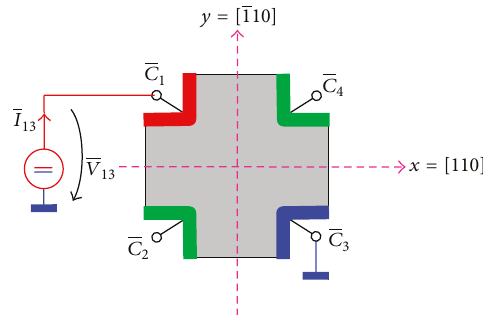
Figure 16: Pseudo-Hall device with two perpendicular mirror- symmetry axes 𝑥 and 𝑦 : inverted Greek cross geometry. It can be used for the measurement of 𝜎 𝑥𝑥 − 𝜎 𝑦𝑦 on a chip made of (100)-silicon. The device is supplied with electrical power at the contacts 𝐶 1 – 𝐶 3 .Theoutputsignalistappedbetween 𝐶 2 and 𝐶 4 .The equivalent resistor circuit (ERC) is identical to Figure 6.